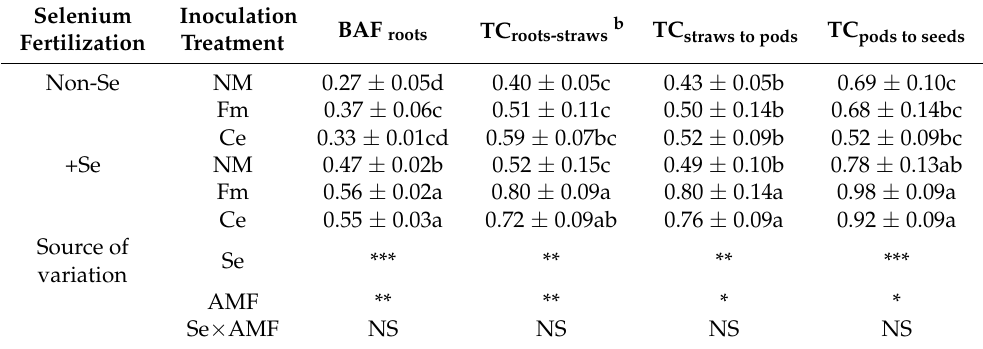
Table 3. Effects of AMF inoculation and Se fertilizations on the bioaccumulation factor (BAF) and transport coefficient (TC S ) of Se in soybean a